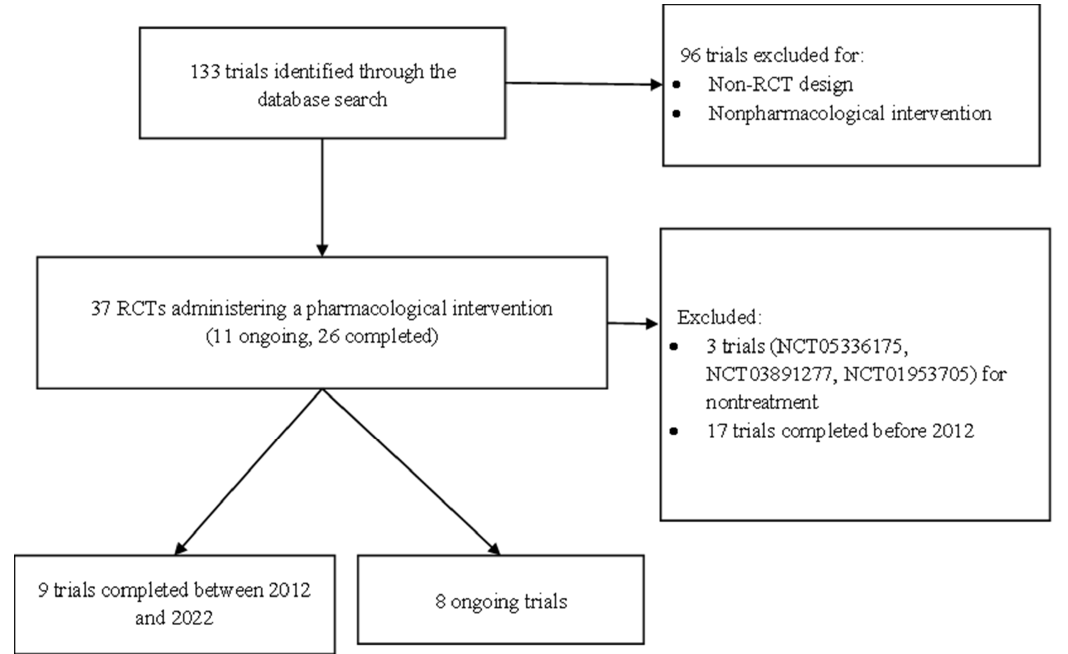
Figure 4. Flowchart of trial selection from a search of ClinicalTrials.gov accessed on 20 May 2022.